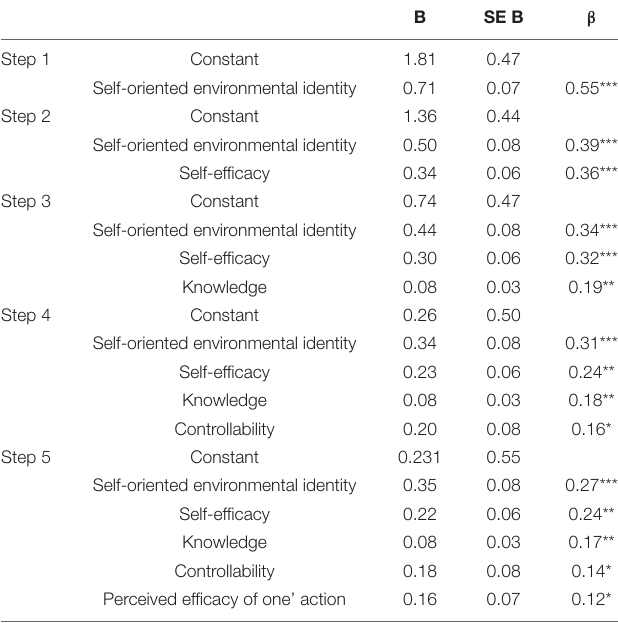
TABLE 2 | Multiple regression: behavioral intention to recycle starting